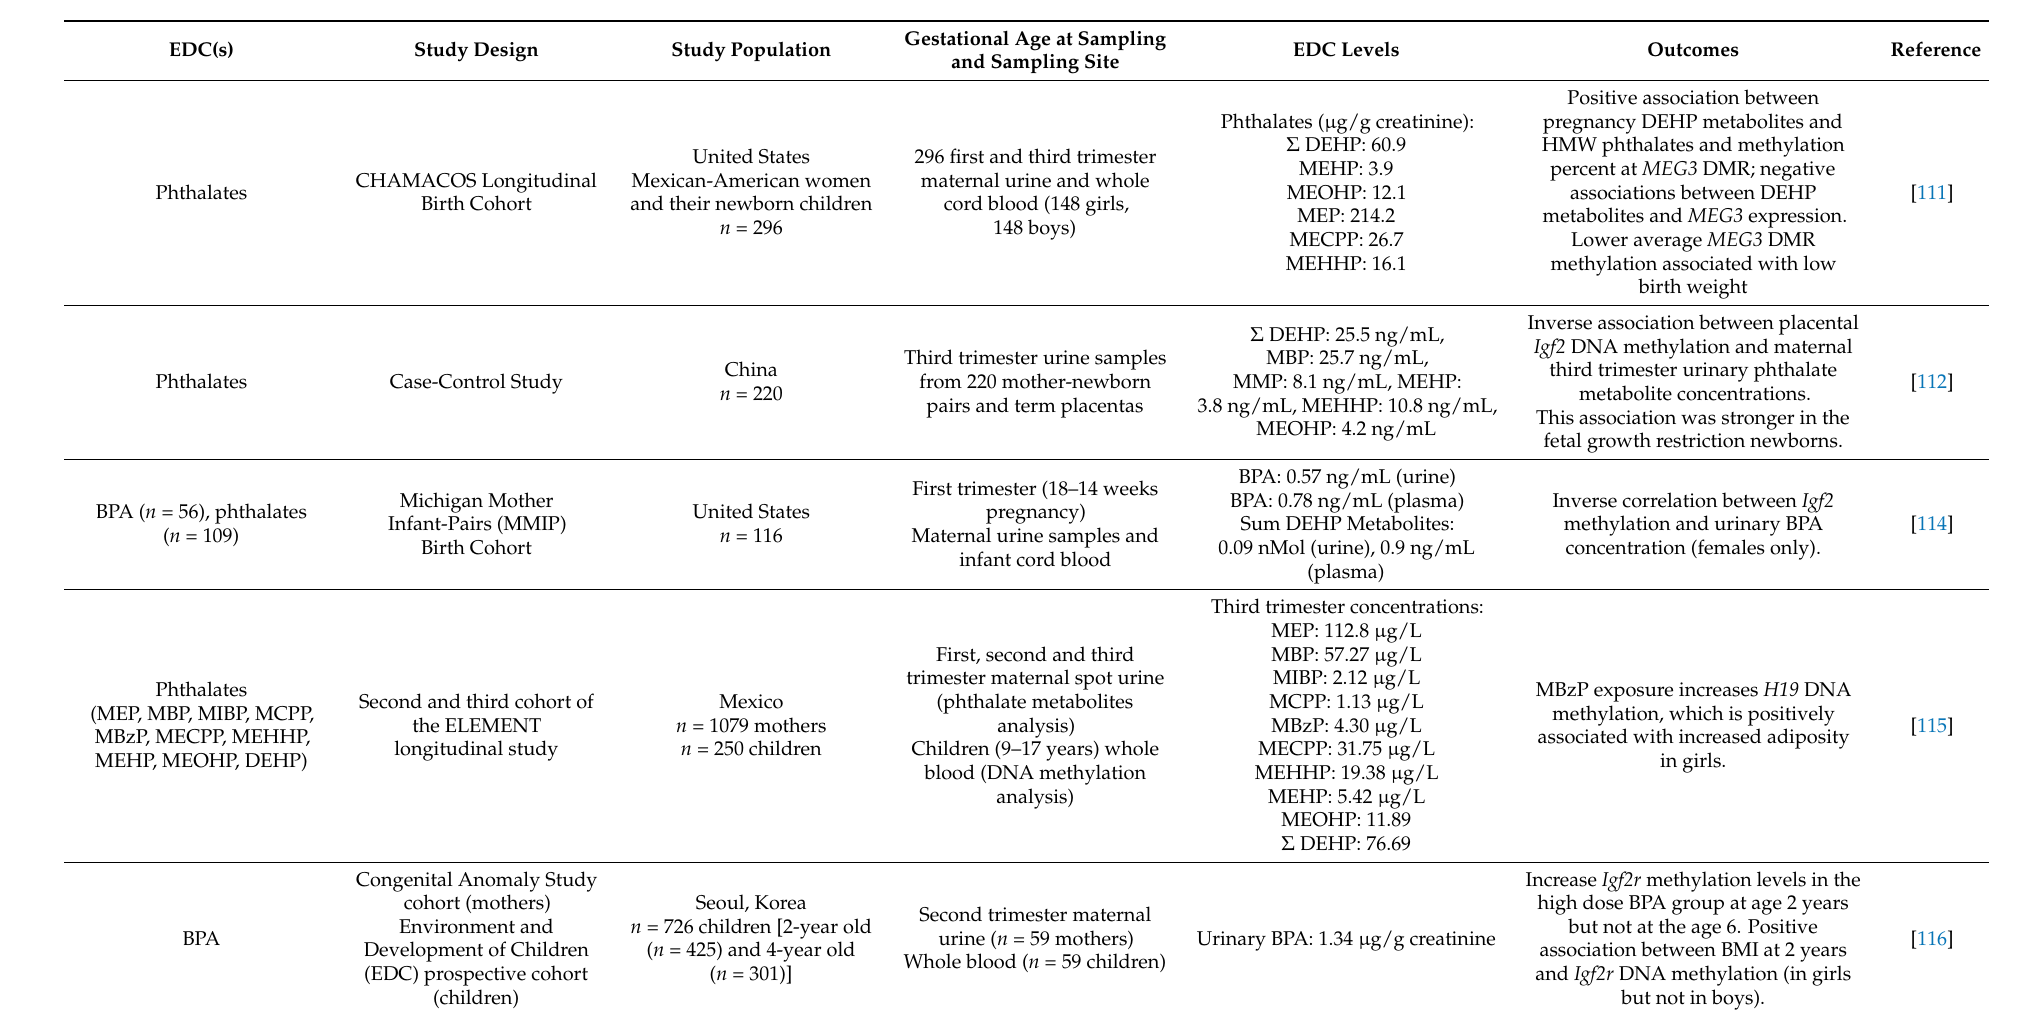
Table 2. Clinical